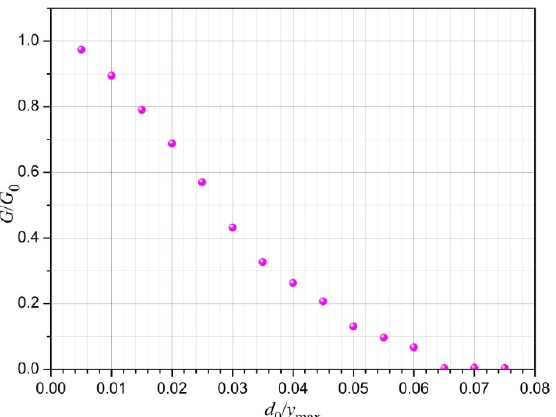
Figure 7. The ratio of the conductivity of the conductive layer with defects to the conductivity of the layer without defects depending on the ratio of the average length of the defect line segments d 0 in relation to the layer width y max . Other simulation parameters are as follows: σ d = 0.2 d 0 , σ α = 25 ◦ , and N = 10.